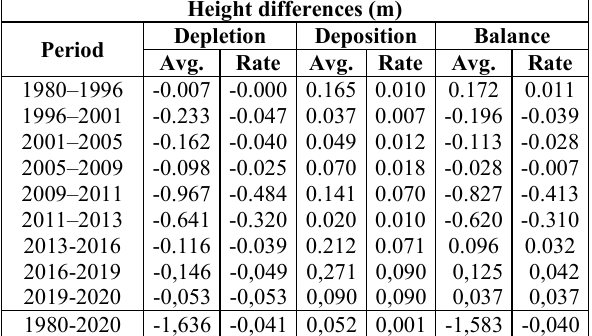
Table 4. Height differences and rates in the gully area.